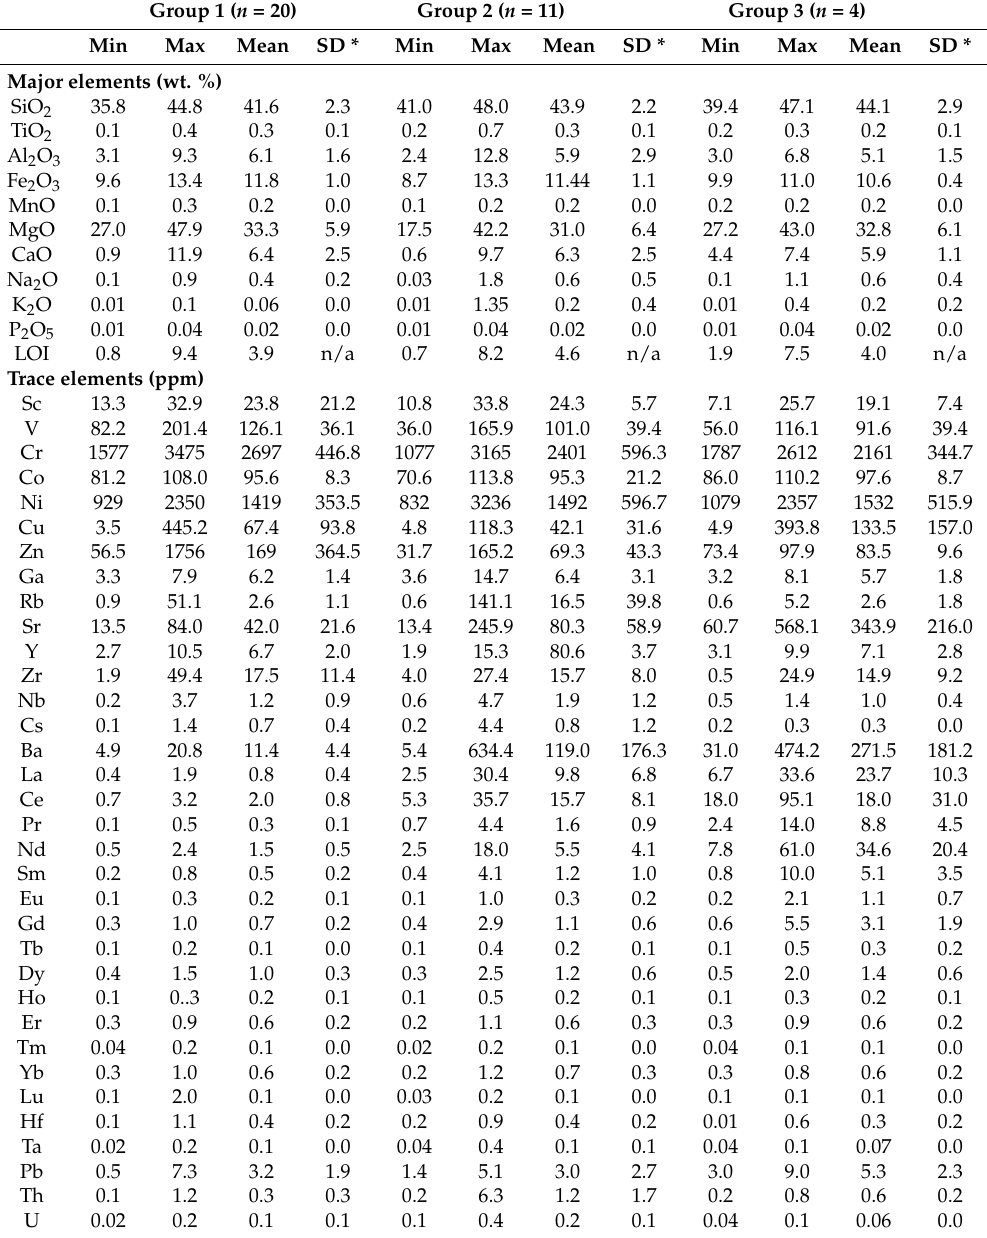
Table 2. Representative bulk-rock analyses of ultramafic rocks from the Ben Strome Complex. Major-element analyses conducted using inductively coupled plasma optical emission spectrometry (ICP-OES). Trace-element analyses conducted using inductively coupled plasma mass spectrometry (ICP-MS). The full dataset is included in the Supplementary Material (Table